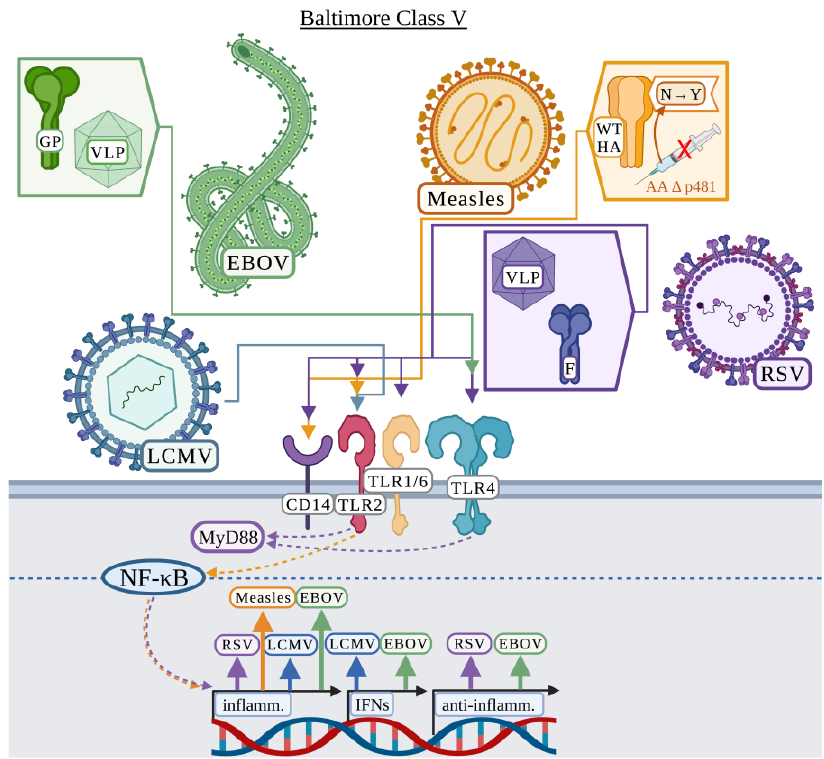
Figure 5. Baltimore Classification V viruses recognized by surface TLRs: the viruses in Baltimore Class V include Ebola virus (EBOV), lymphocytic choriomeningitis (LCMV), measles, and respiratory syncytial virus (RSV). The primary ligand identified for EBOV is GP, and VLPs composed of VP40, and GP have been demonstrated to activate an inflammatory, anti-inflammatory, and IFN